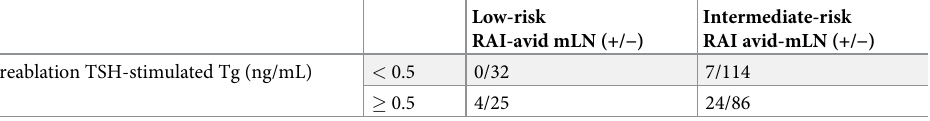
Table 3. Prevalence of RAI-avid mLN according to risk group and preablation TSH-stimulated serum Tg level. Preablation TSH-stimulated Tg (ng/mL) < 0.5 0/32